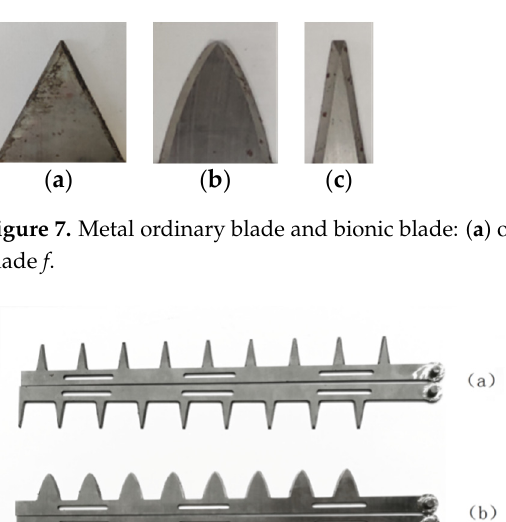
Figure 6. Lade geometric parameters: ( a ) ordinary blade; ( b ) bionic blade e ; ( c ) bionic blade f ; and ( d ) blade side. Note: a 1 is tooth crest width, mm; a 2 is tooth root width, mm; L is tooth height, mm; n is tooth root width of bionic blade e , mm; m is tooth root width of bionic blade f , mm; α is internal angle of the bionic blade, °; β is other internal angle of the bionic blade, °; θ is blade edge angle, °; b is tooth thickness.